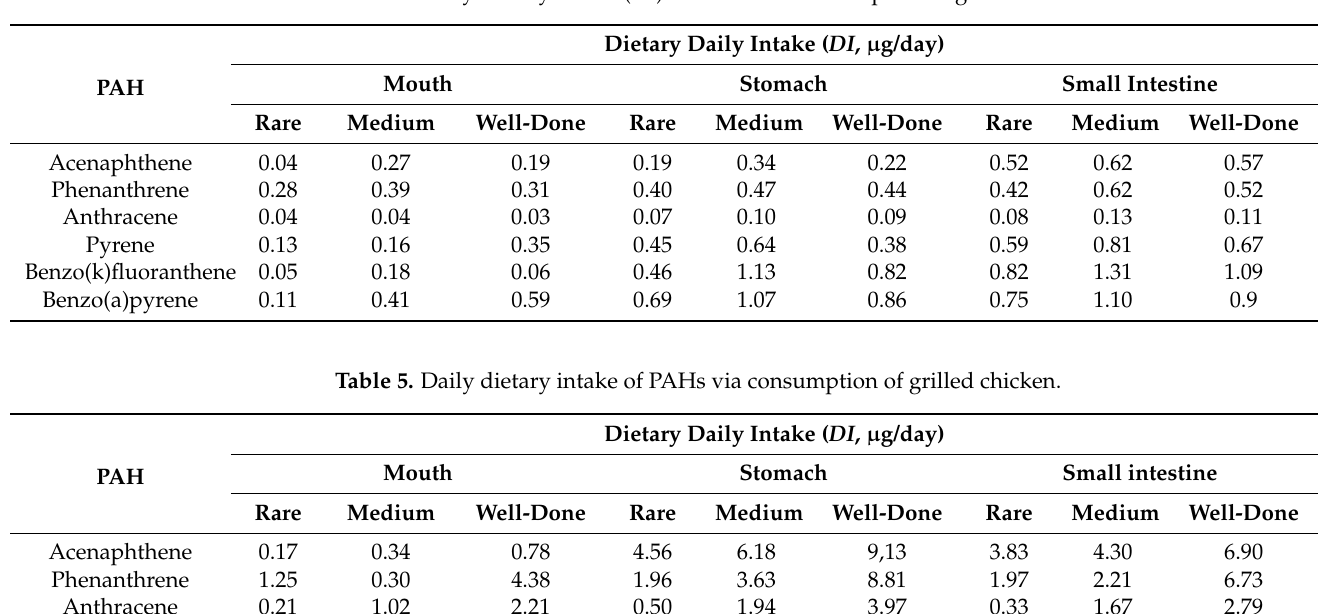
Table 4. Daily dietary intake ( DI ) of PAHs via consumption of grilled beef.